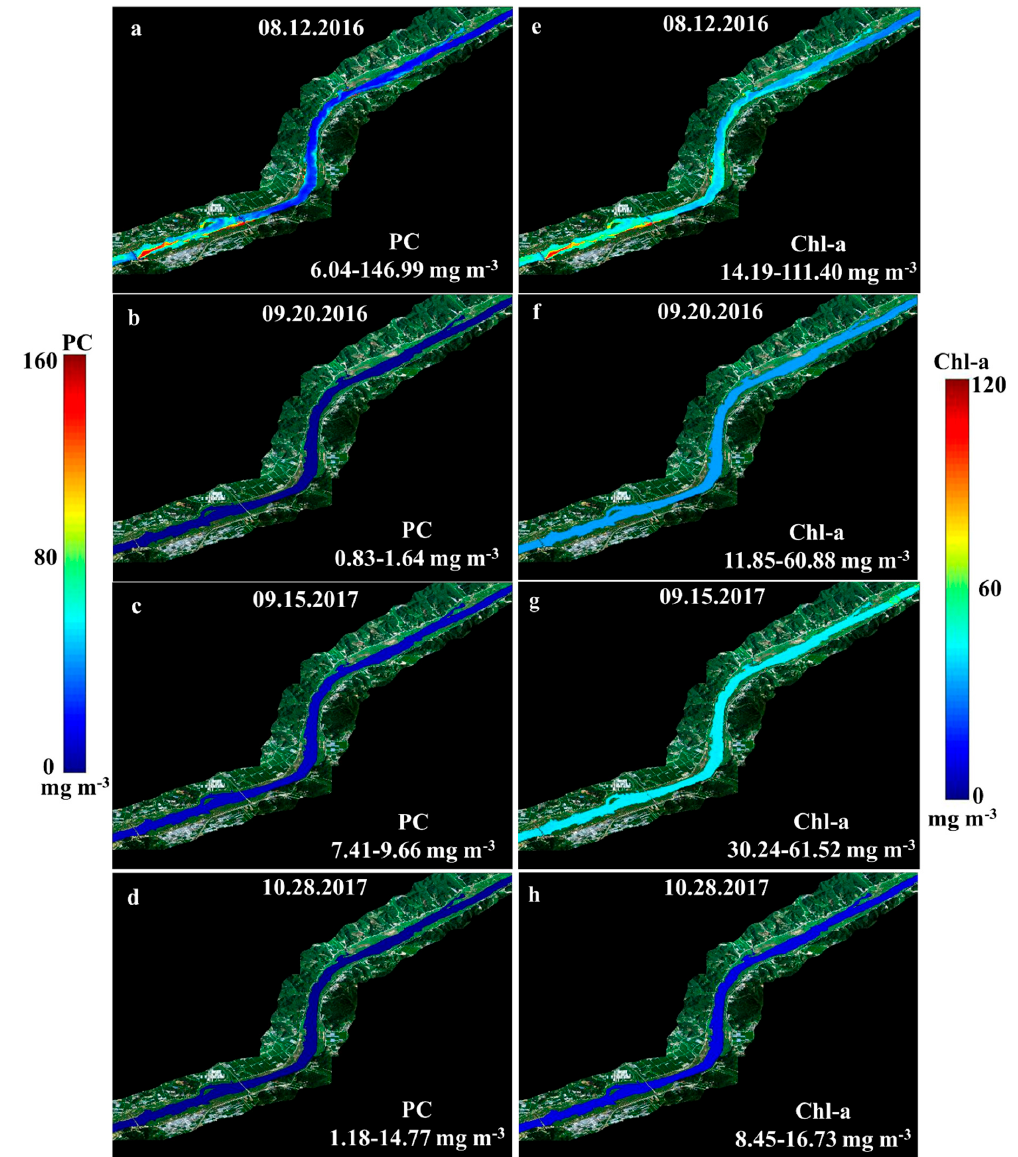
Figure 9. Temporal variations in cyanobacterial maps of SAE-ANN: ( a–d ) PC variation for August